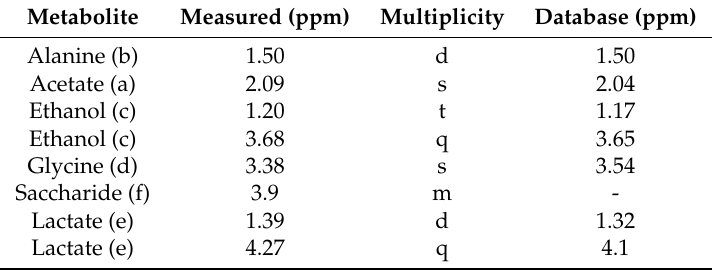
Table 1. The peaks from the 1 H NMR spectrum that were acquired during the last run. In ‘s’ stands for a singlet, ‘d’ a doublet, ‘dd’ a doublet of doublets, ‘t’ a triplet, ‘q” a quartet, and ’m’ a multiplet under mutiplicity column. For the multiplets, the peak is equal to the center. Database comparison to the HMDB